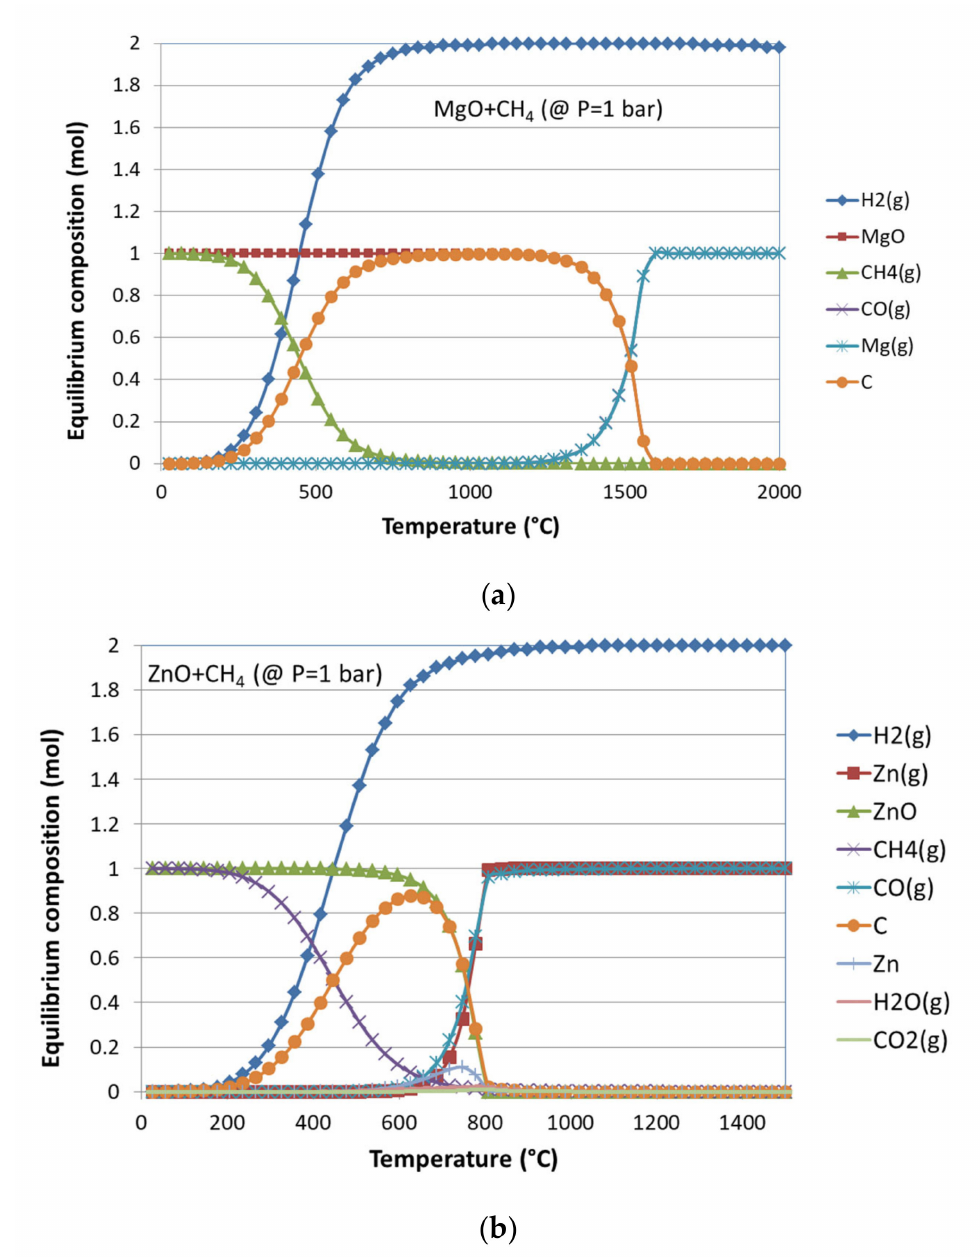
Figure 6. Influence of temperature on equilibrium product distribution for the methano-thermal reduction of ( a ) MgO and ( b ) ZnO (at P = 1